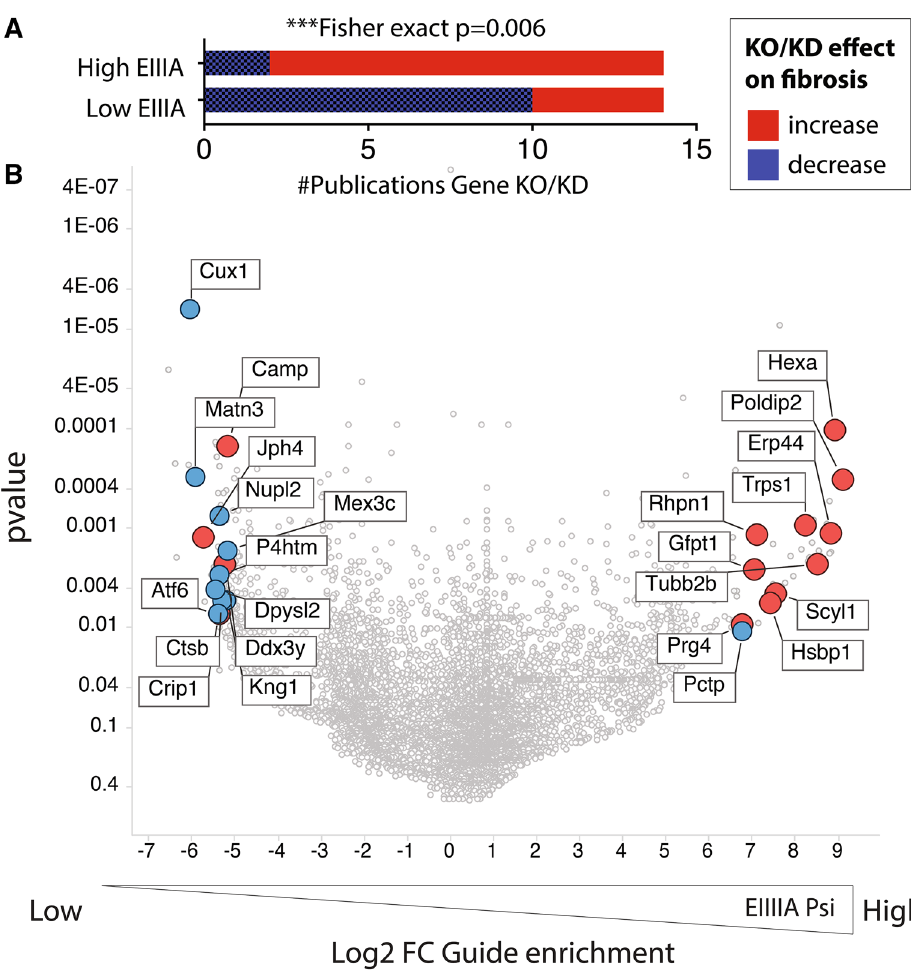
Figure 4. FN splicing regulators correlate with fibrotic phenotypes. ( A,B ) Analysis of top regulatory genes from CRISPR screen in publicly available data. ( A ) Graph showing the literature supporting either an increase or decrease in fibrotic effects in mice or cells in culture, following gene deletion or suppression. The top 100 most enriched genes in cells with either increased EIIIA inclusion or decreased EIIIA inclusion were assessed. ( B ) Volcano plot, showing the genes with literature support for effects on fibrotic responses, positively or